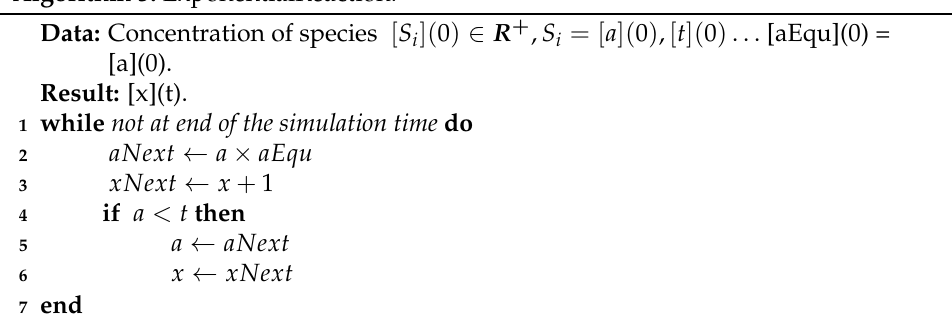
Algorithm 3 can simulate its value through the input and repeated use of the basic calculation module. The calculation of the simulation function obtained high accuracy results in CRN++. The input data selected in the simulation were: b = 5; the calculation result was x = 148.413, which can be accurate to the last three decimal places; when b = 10, the calculation result was x = 22,026.5; the result is shown in Figure 6c,d. Algorithm 3: